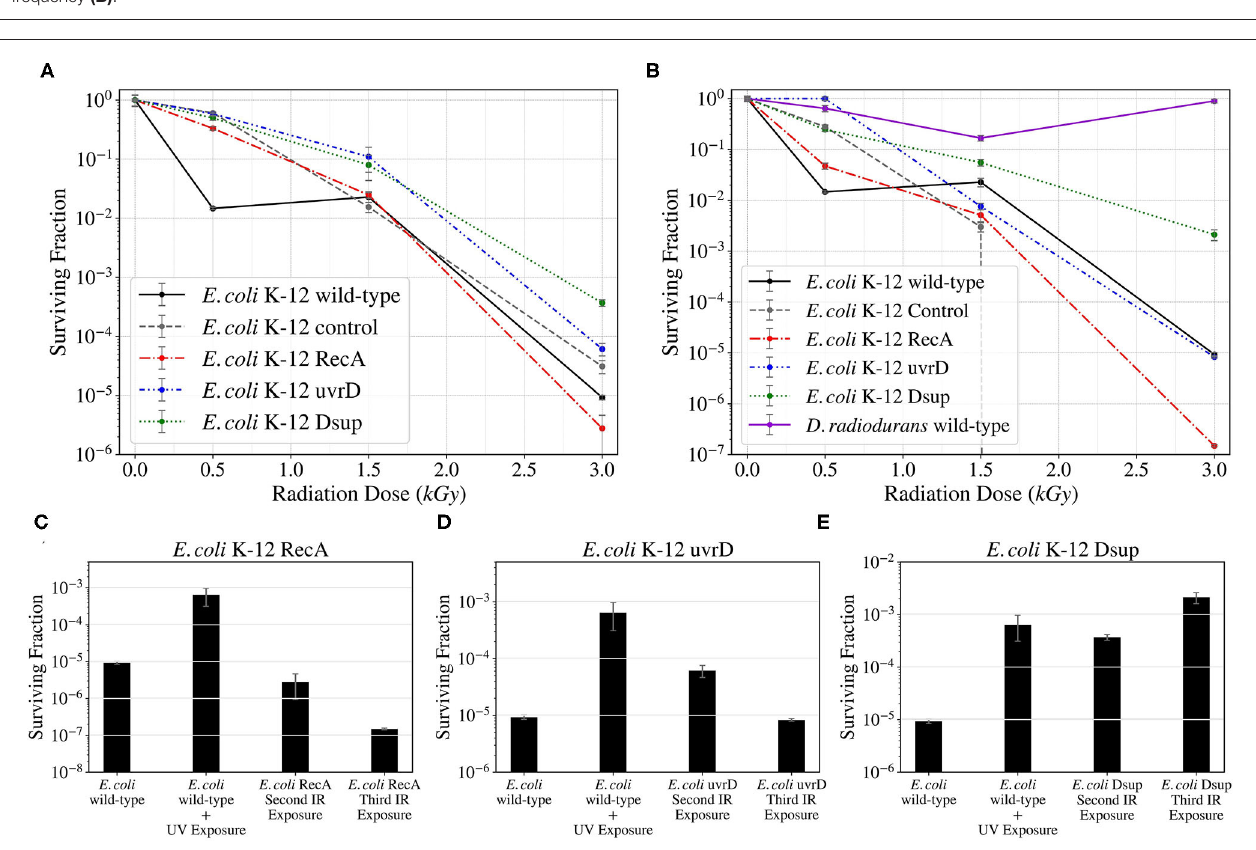
FIGURE 5 | Survival curves for the different E. coli strains and D. radiodurans for the second (A) and third (B) Ionizing Radiation exposures as part of the directed evolution process; and progress bars of the survival of the RecA (C) , uvrD (D) , and Dsup (E) strains through the different Ionizing Radiation exposures.